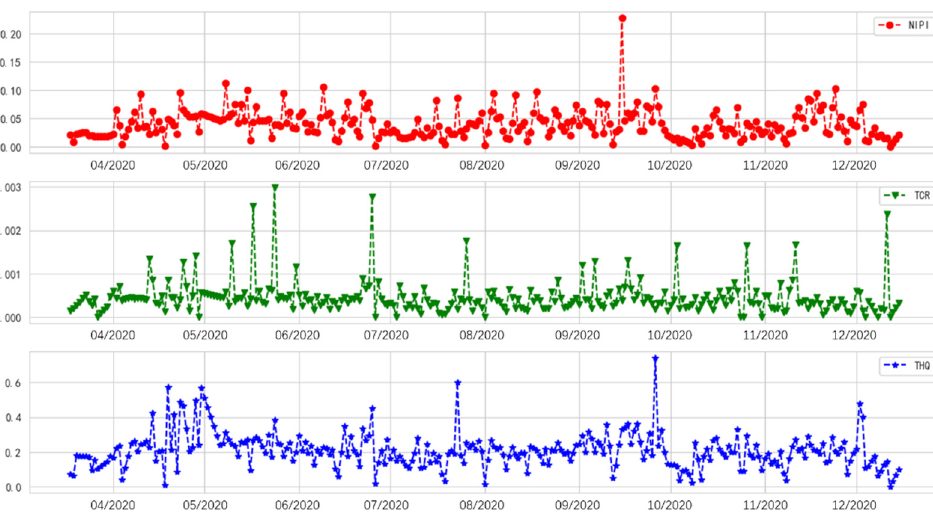
Figure 8. Assessment index calculation using the AHP-EW.